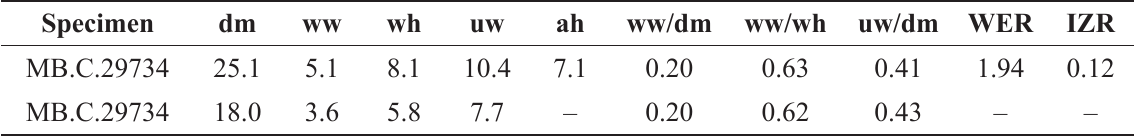
Table 6. Conch dimensions (partly estimated) and ratios of selected specimens of Arasella falcata Korn & Hairapetian sp. nov. from Baghuk